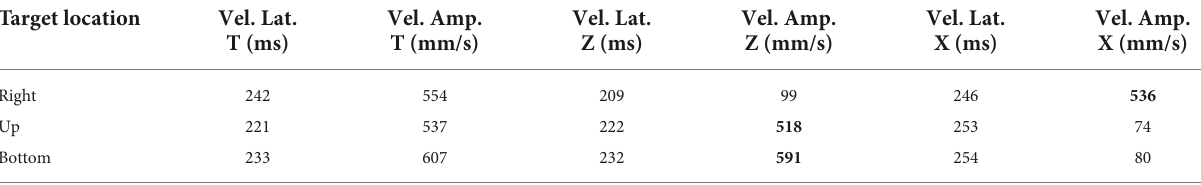
TABLE 1 Latencies and amplitudes of the velocity peaks for tangential (T), vertical (Z) and horizontal (X) displacement of the participants’ index finger when pointing to visually cued targets located on the right, upwards and downwards. Target